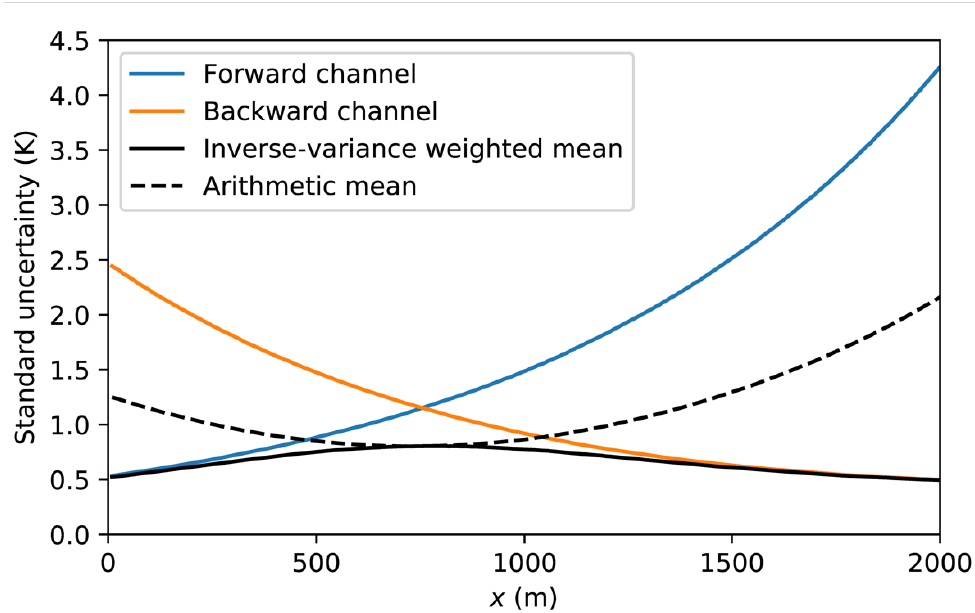
Figure 6. Synthetic example of the standard uncertainty of the estimated temperature using arithmetic mean and the inverse-variance weighted mean.